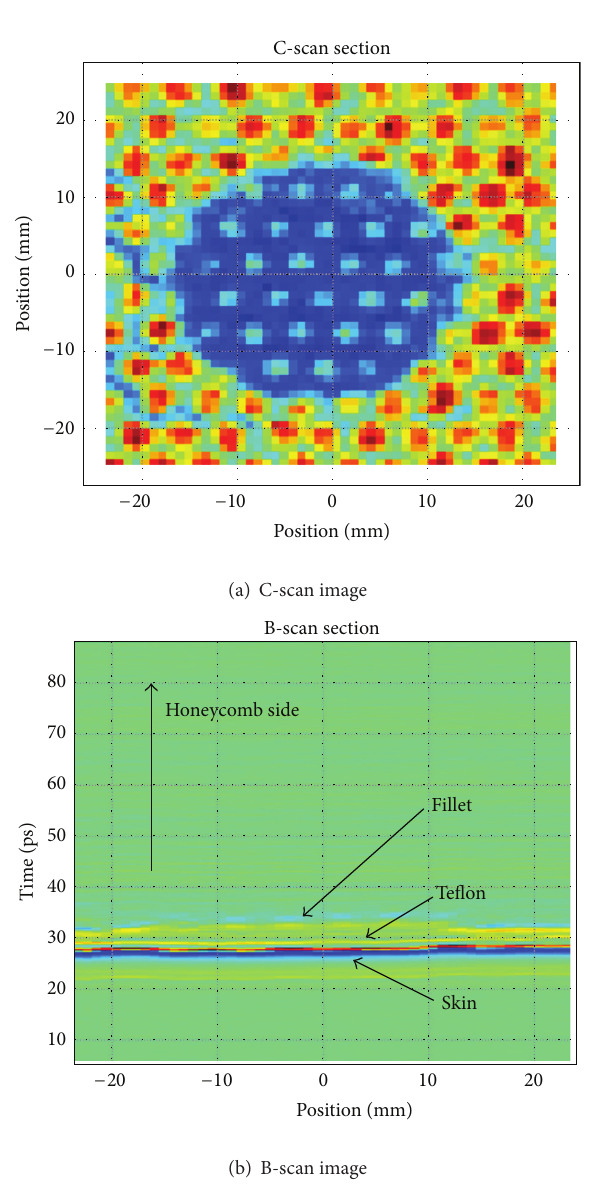
Figure 9: Embedded defects in Kevlar/Nomex honeycomb sand- wich. (a) C-scan image based on amplitude and (b) B-scan image in the horizontal middle location of image